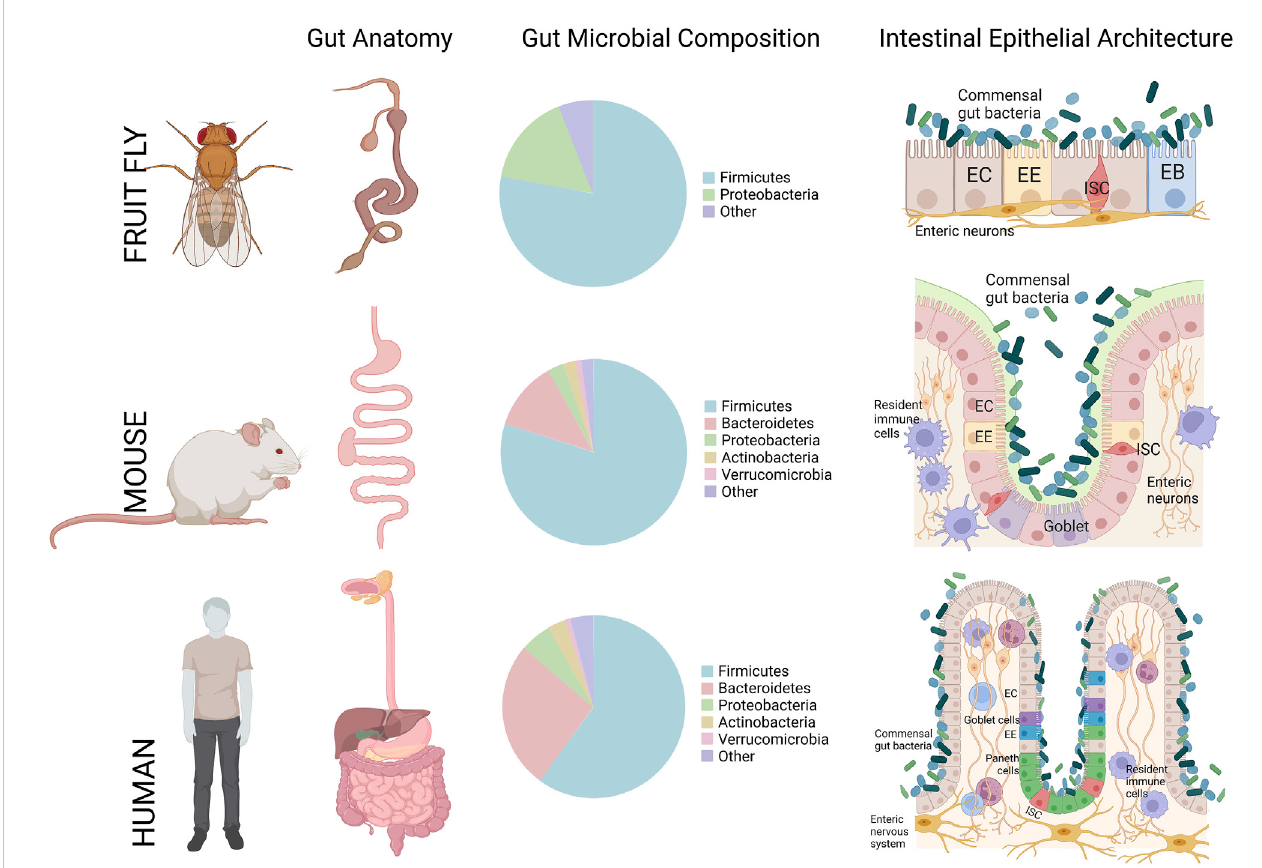
FIGURE 3 A cross-comparison of the gastrointestinal tract gross anatomy, gut microbiota composition, and general intestinal epithelial architecture between Drosophilamelanogaster (Fruit fl y), Musmusculus (Mouse),and Homosapiens (Humans).Inthesmallintestine,formouseandhuman,andmidgut,forthefruit fl y,allthreespeciesshare Firmicutes and Bacteroidetes microbialpopulationasthedominantresidentphyla.FigureconstructedonBioRender.com,piecharts of common phyla that compose the gut-microbiota are referenced from (Trinder, et al.,